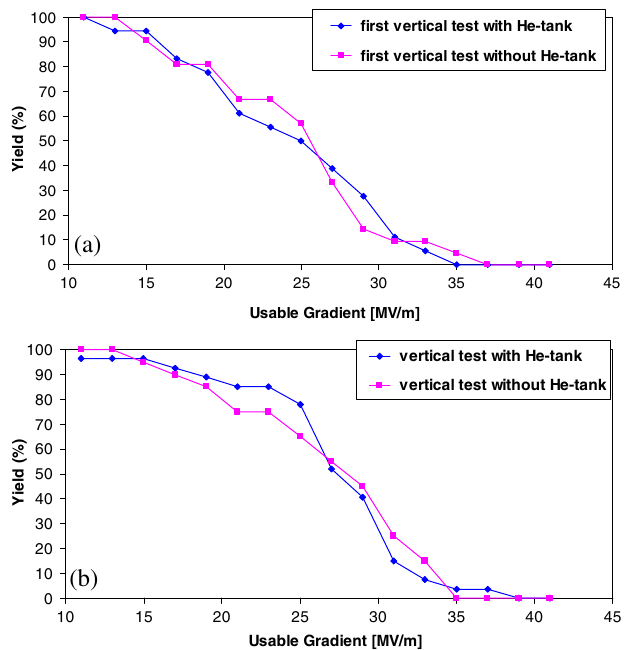
FIG. 7. (Color) Yield plot of usable gradient for first (top) and last (bottom) vertical rf acceptance test depending on preparation strategy: ‘‘vertical rf test with He tank’’ or ‘‘vertical rf test without He